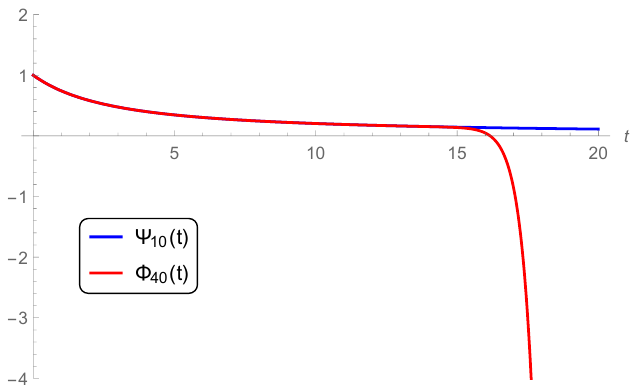
Figure 3. Comparison between Ψ 10 (present) and Φ 40 (Ref. [9]) at λ = 1, q = 1.5, and α = 1 (ordinary derivative).